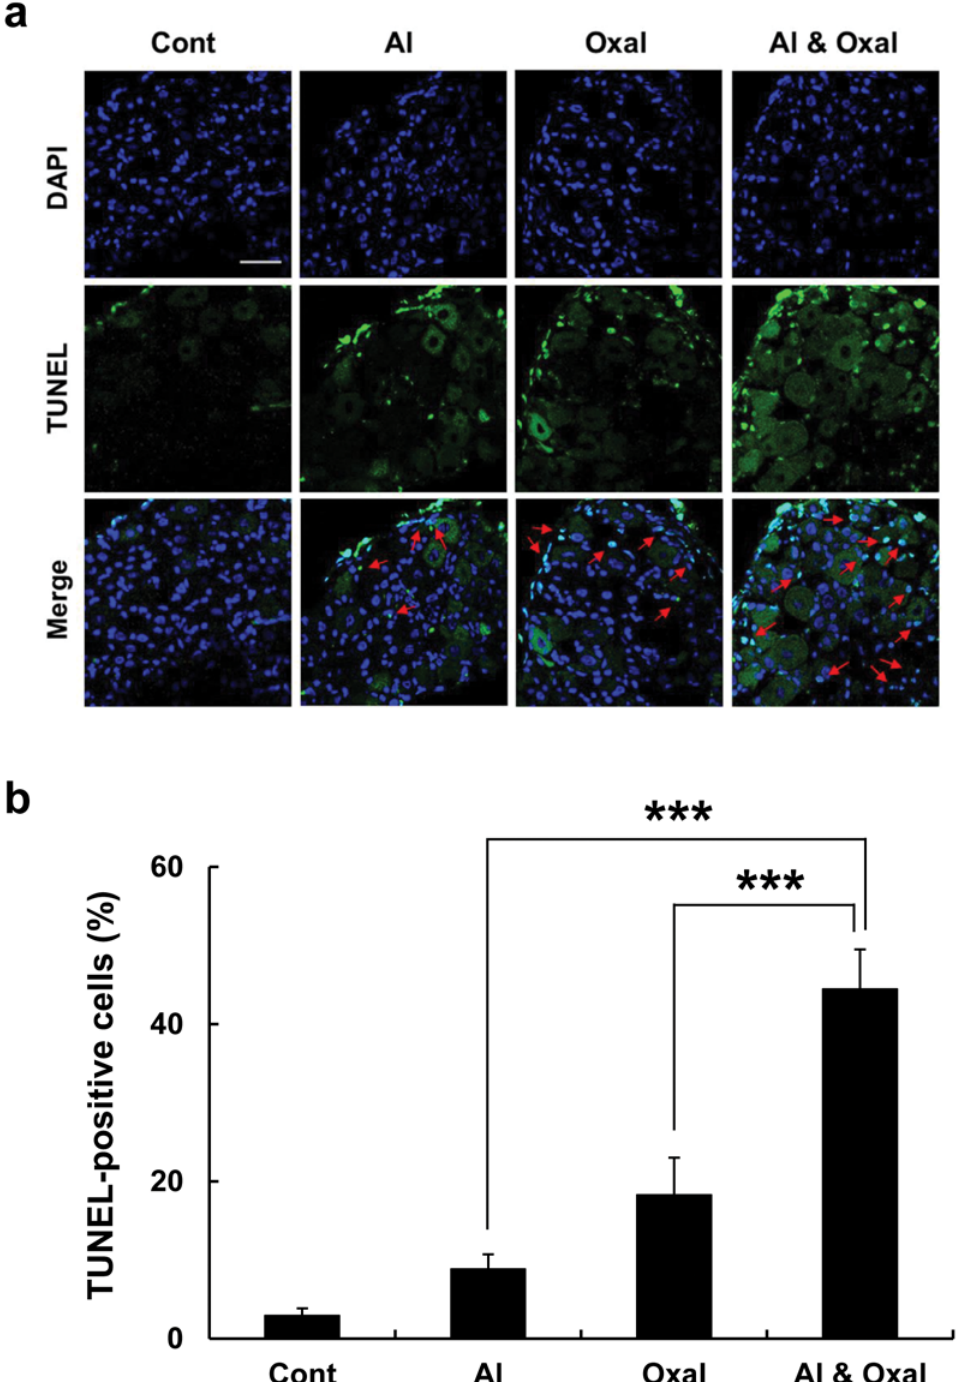
Fig 8. Cell death in DRGs after treatment with oxaliplatin and Al. (a) Cryo-sectioned DRG tissues of Cont (5% dextrose), Al (aluminum chloride, 7 mg/kg; equivalent 0.78 mg/kg of elemental Al), Oxal (oxaliplatin, 3 mg/kg), and Al & Oxal (aluminum chloride 7 mg/kg and oxaliplatin 3 mg/kg) groups were stained using terminal deoxynucleotidyl transferase-mediated dUTP nick end-labeling (TUNEL; green) to evaluate apoptosis. Nuclei were stained with DAPI (blue) and visualized using a confocal scanning microscope. The increase in apoptosis in the DRG from the Al & Oxal group was significant compared to the Oxal and Al groups (red arrows). Scale bar = 40 μ m for all panels. (b) Depicting a statistical analysis of TUNEL positive cells. The number of TUNEL positive cells was counted. Values are expressed as the mean ± SEM ( n = 3 per group). *** p < 0.001 compared with Al